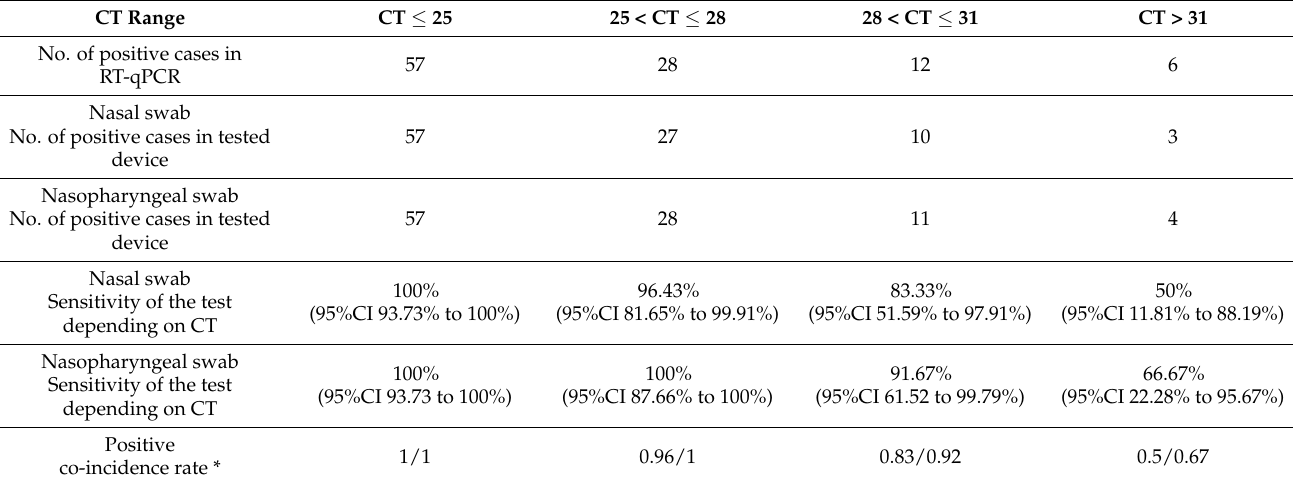
Table 5. Positive samples (determined by the reference method) divided according to the CT com- pared to GenBody COVID-19 Ag RATs in nasal and nasopharyngeal